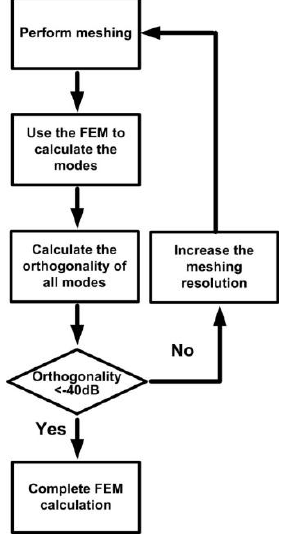
Figure 4. A flow diagram of error examination for FEM.